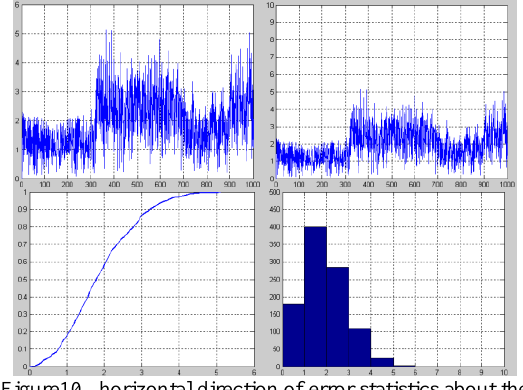
Figure10. horizontal direction of error statistics about the integrated positioning under